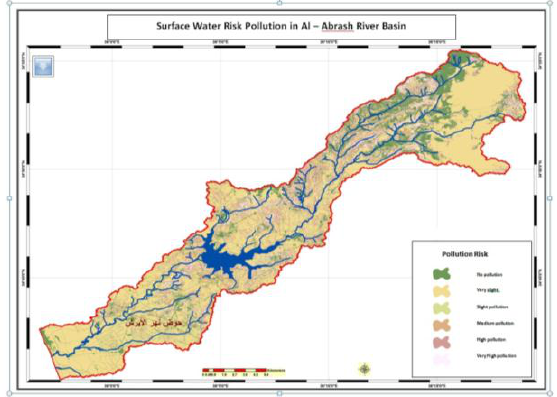
Figure 4: surface water pollution risk